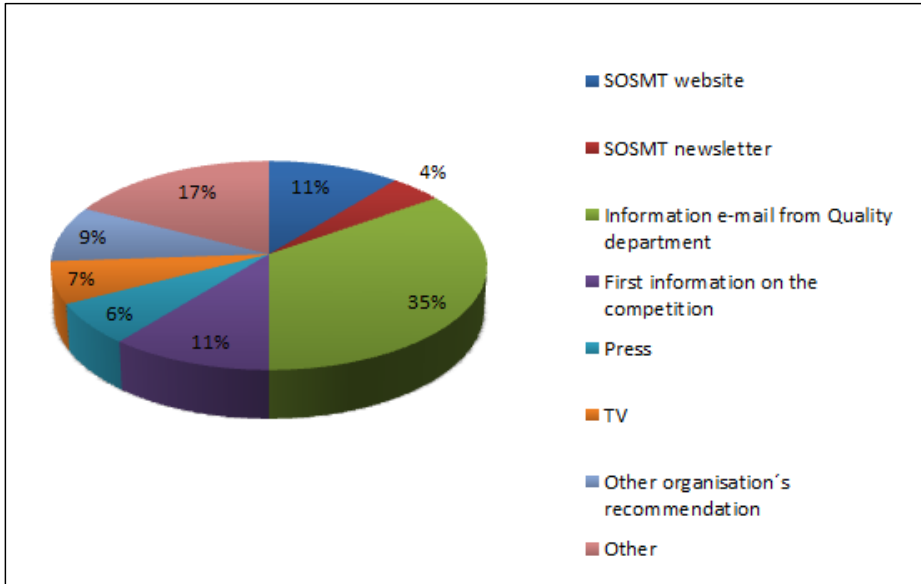
Fig. 2 Results of question 1: How did you become aware of the